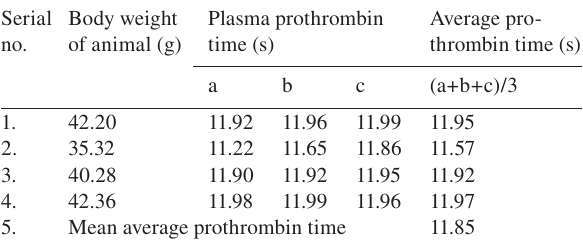
Table 1 Normal anticoagulation action without any drug in albino